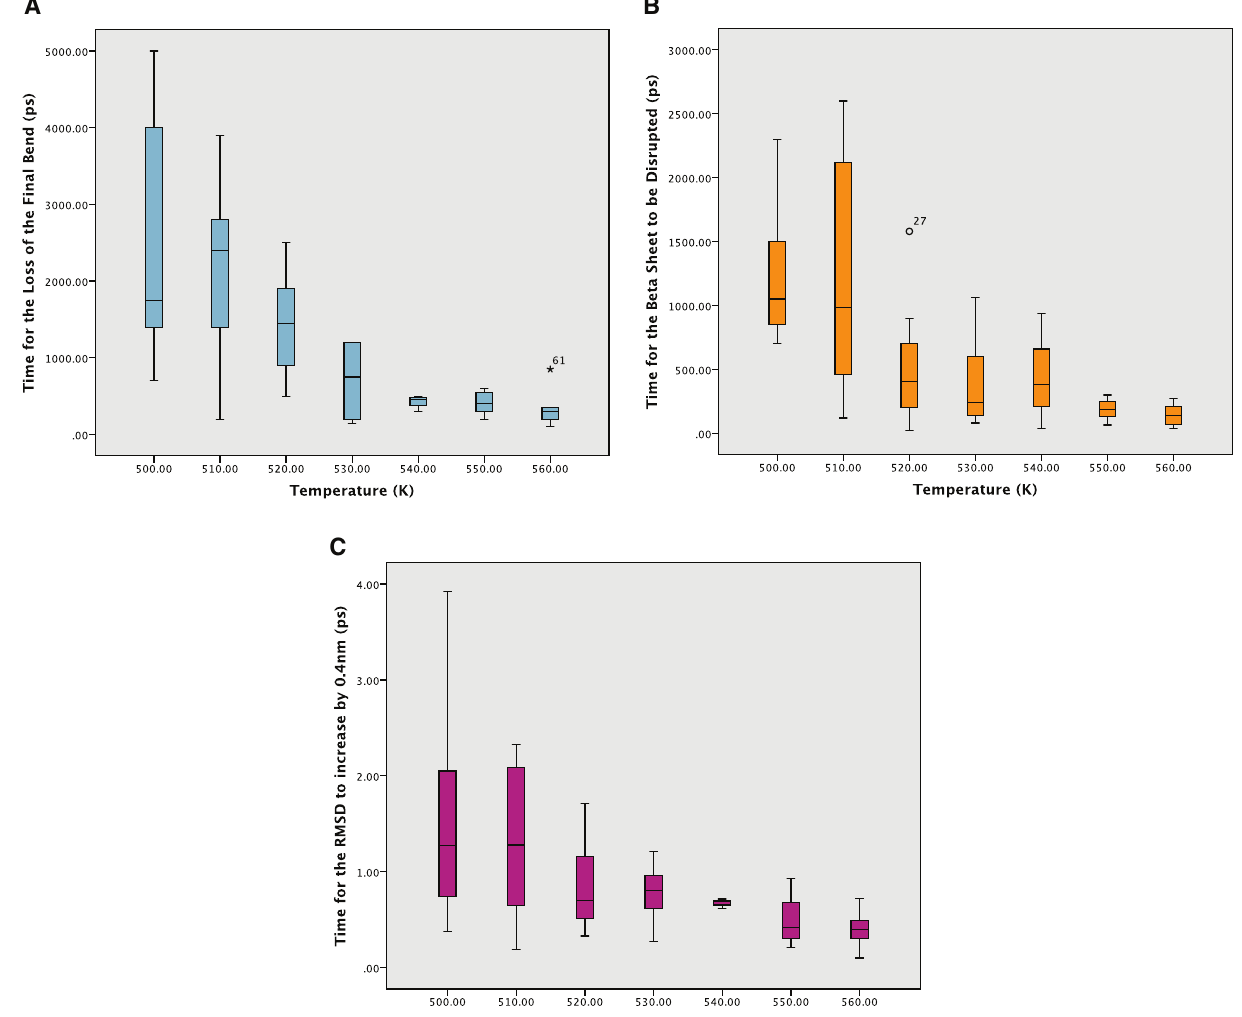
Figure 2. A : Boxplot of the times for the loss of the final bend from the secondary structure in picoseconds. Outliers are labelled. B : Boxplot of the times for the loss of the beta sheet in picoseconds. Outliers are labelled as circles or numbers if they are extreme. C : Boxplot of the times for the RMSD to go above 0.4nm from the crystal structure in